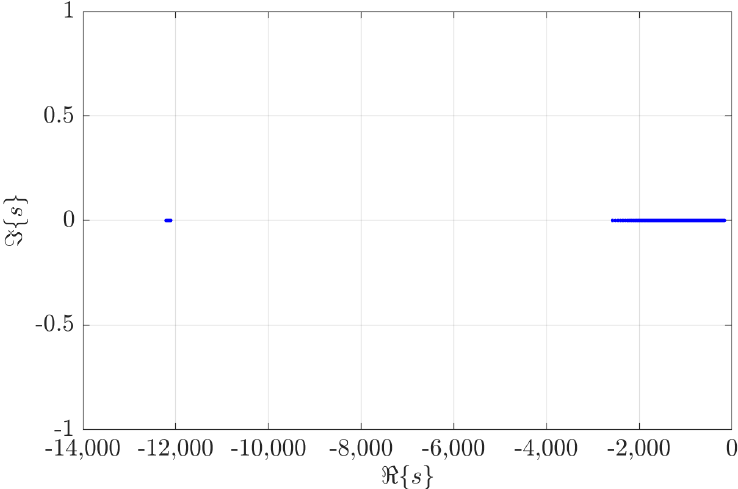
Figure 4. Distribution of eigenvalues for the controlled